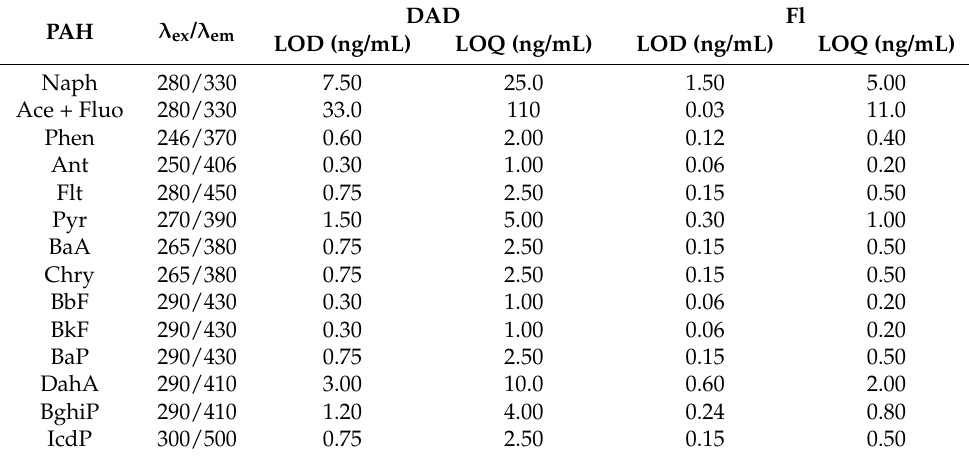
The quantification was carried out using the calibration curves prepared. The cali- bration curves were built by linear regression of the peak areas of the standard solutions against their concentrations. Instrumental limit of detections (LODs) and quantifications (LOQs) were calculated as the lowest observable concentration giving a signal/noise ratio of 3:1 and 10:1, respectively. A DAD and Fl chromatograms of a PAH mixture are shown in Figure 1.